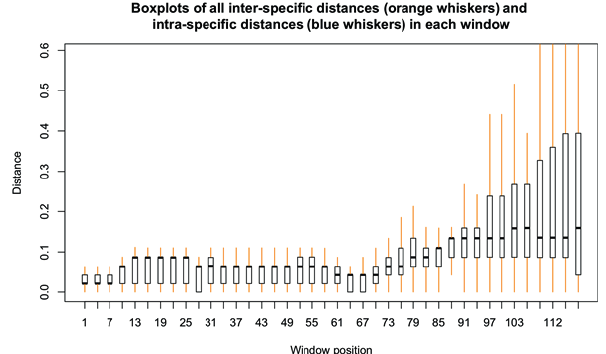
Figure 6. Window sliding of trnHG-psbA sequences in Avicennia species, showing that these species differ in mini-barcodes.